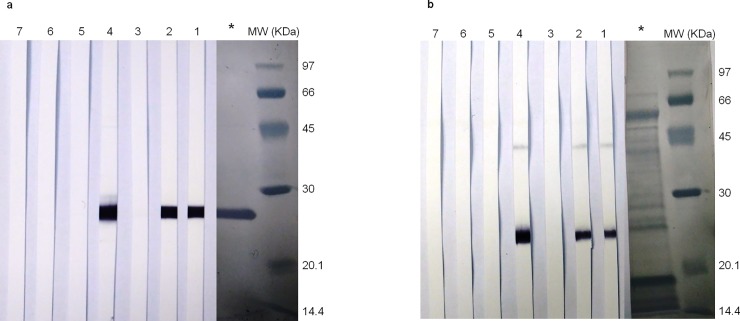
Immune recognition of rHc23 and Adult soluble extract (ASE) by lambs vaccinated with rHc23.Fig 2A: Immune recognition of rHc23 (2.65 μg/cm of gel) by pooled sera from the experimental groups of vaccinated lambs on week 3 post challenge. Fig 2B: Immune recognition of ASE (14.7 μg/cm of gel) by pooled sera from the experimental groups of vaccinated lambs on week 3 post challenge. Proteins were separated by SDS-PAGE and pooled sera were 1/100 diluted. Lane 1: G1; lane 2:G2; lane 3: G3; lane 4: G4; lane 5:G5; lane 6: G6; lane 7: G7. MW: molecular weight markers. *: Amido black stain of membrane with the transferred protein. See Table 1 for details of the groups.